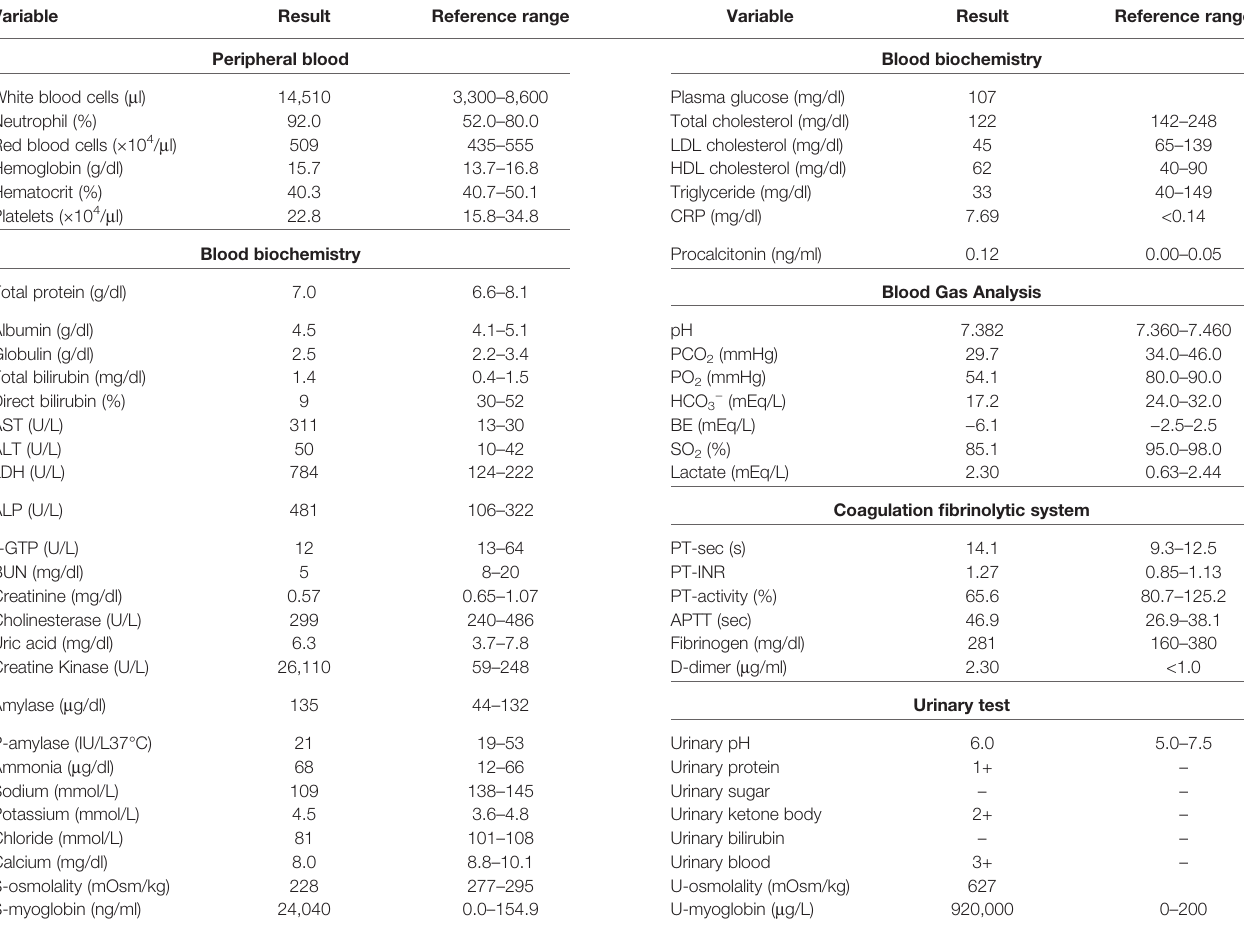
TABLE 1 | Laboratory data in an emergency room in this